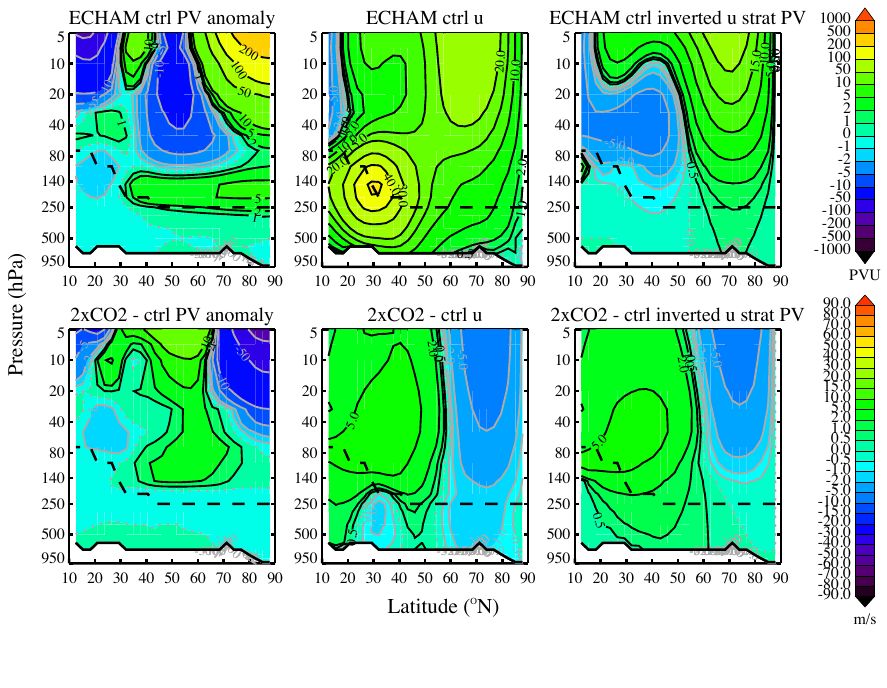
Fig. 6. Same as Figure 5 but for the ECHAM model. Fig. 6. Same as Fig. 5 but for the ECHAM model.